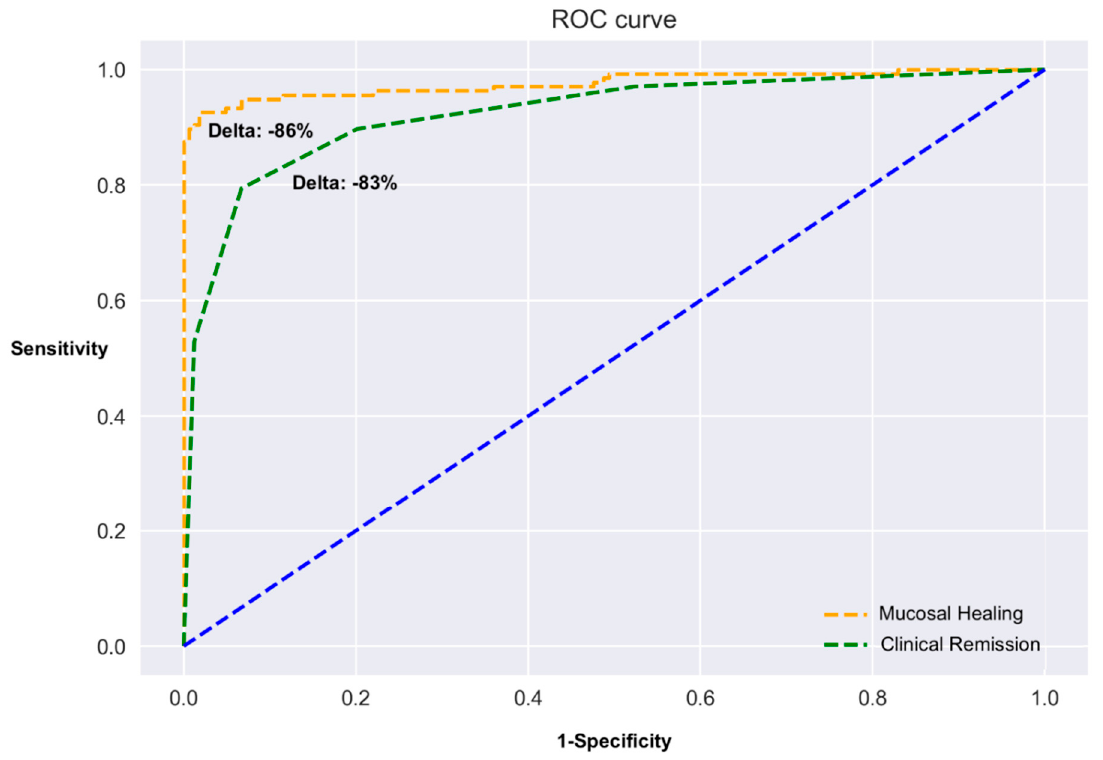
Figure 2. Receiver operating characteristics (ROC) curve assessing the predictive performance of delta (% change) fecal calprotectin after induction with respect to baseline for mucosal healing and clinical remission.